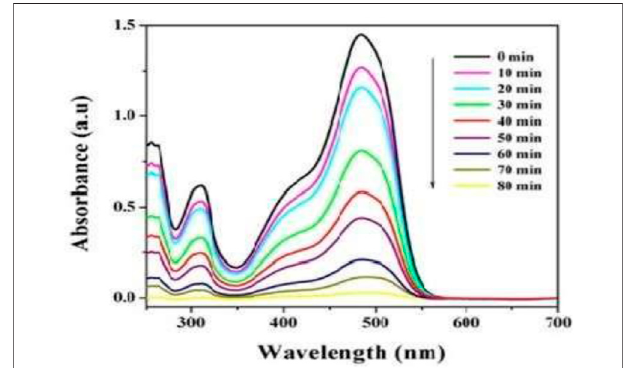
FIGURE 3 | UV-Vis spectral report of the dye Acid Orange.